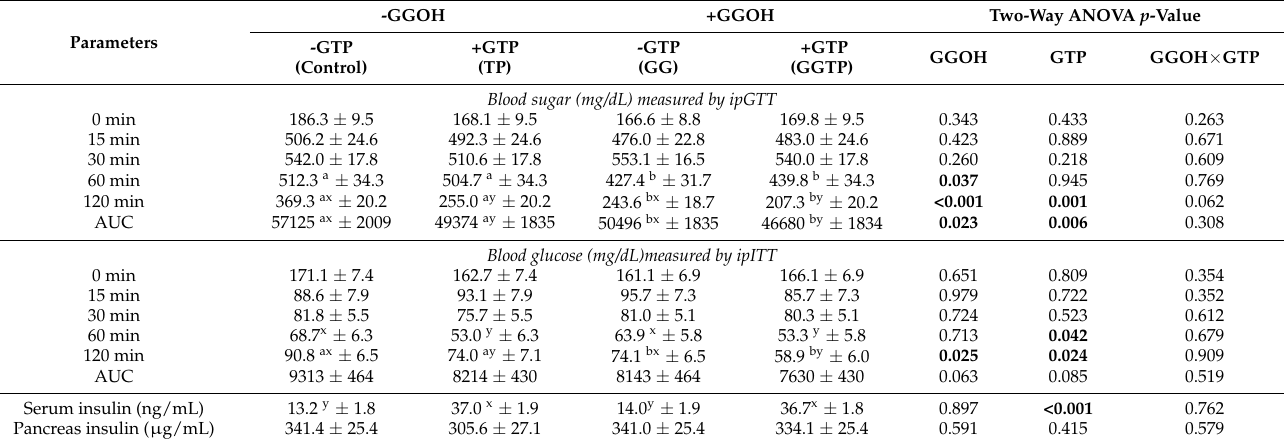
Table 1. Effect of geranylgeraniol (GGOH) and green tea polyphenols (GTP) on blood glucose and AUC during ipGTT and ipITT, serum insulin concentration, and pancreas insulin concentration.